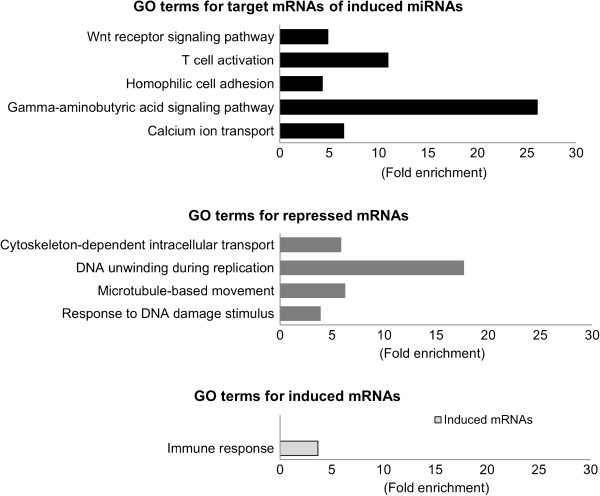
Gene ontology (GO) annotation of differentially expressed genes and target genes of differentially expressed miRNAs between lungs of AIV infected and non-infected chicken in biological process category (P < 0.05). Fold enrichment is a ratio obtained by dividing user’s percentage by the percentage of each category of the whole genome.